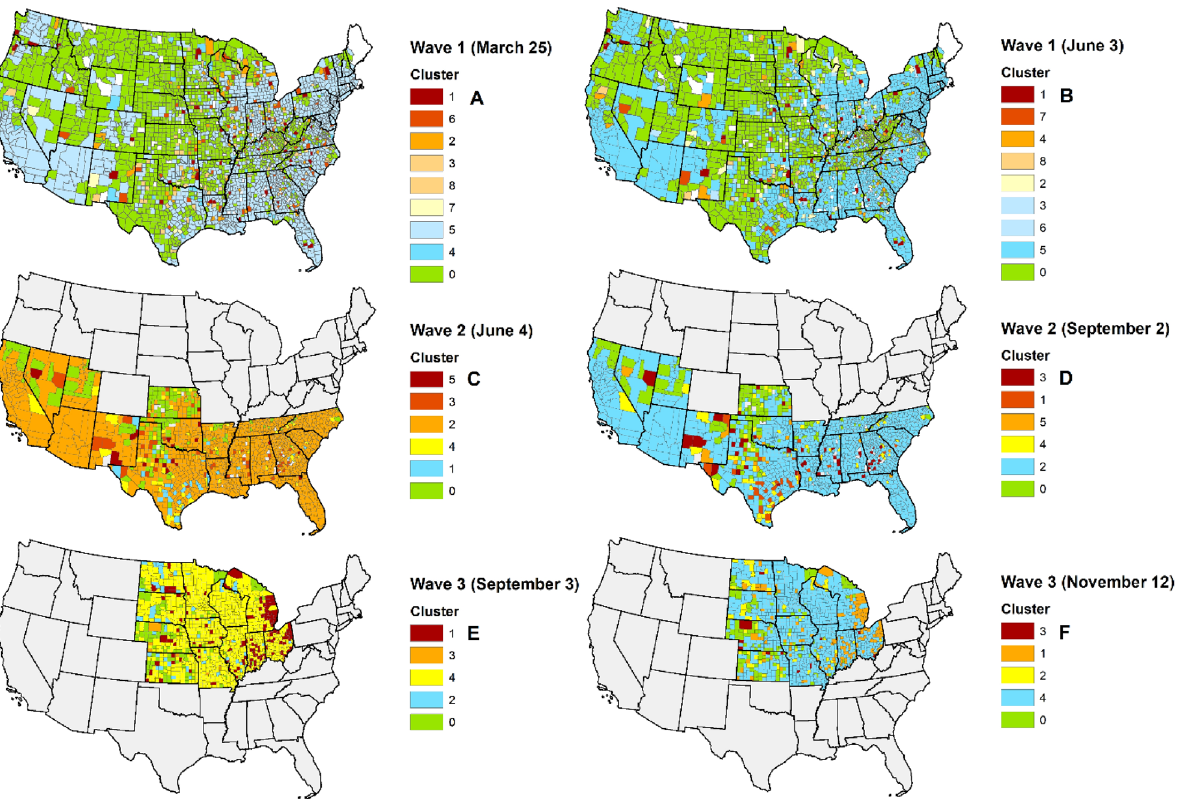
Figure 3. Geographical distribution of the clusters of U.S. counties based on the estimated COVID-19 MIR growth trajectories at the: ( A) beginning of the1st wave (Mar 25, 2020), ( B) end of the 1st wave (Jun 3, 2020), ( C) beginning of the 2nd wave (Jun 4, 2020), ( D) end of the 2nd wave (Sep 2, 2020), ( E) beginning of the 3rd wave (Sep 3, 2020), and ( F) end of the 3rd wave (Nov 12, 2020). Red color indicates the highest MIR, blue color indicates the lowest MIR, and green color shows the counties with MIR =